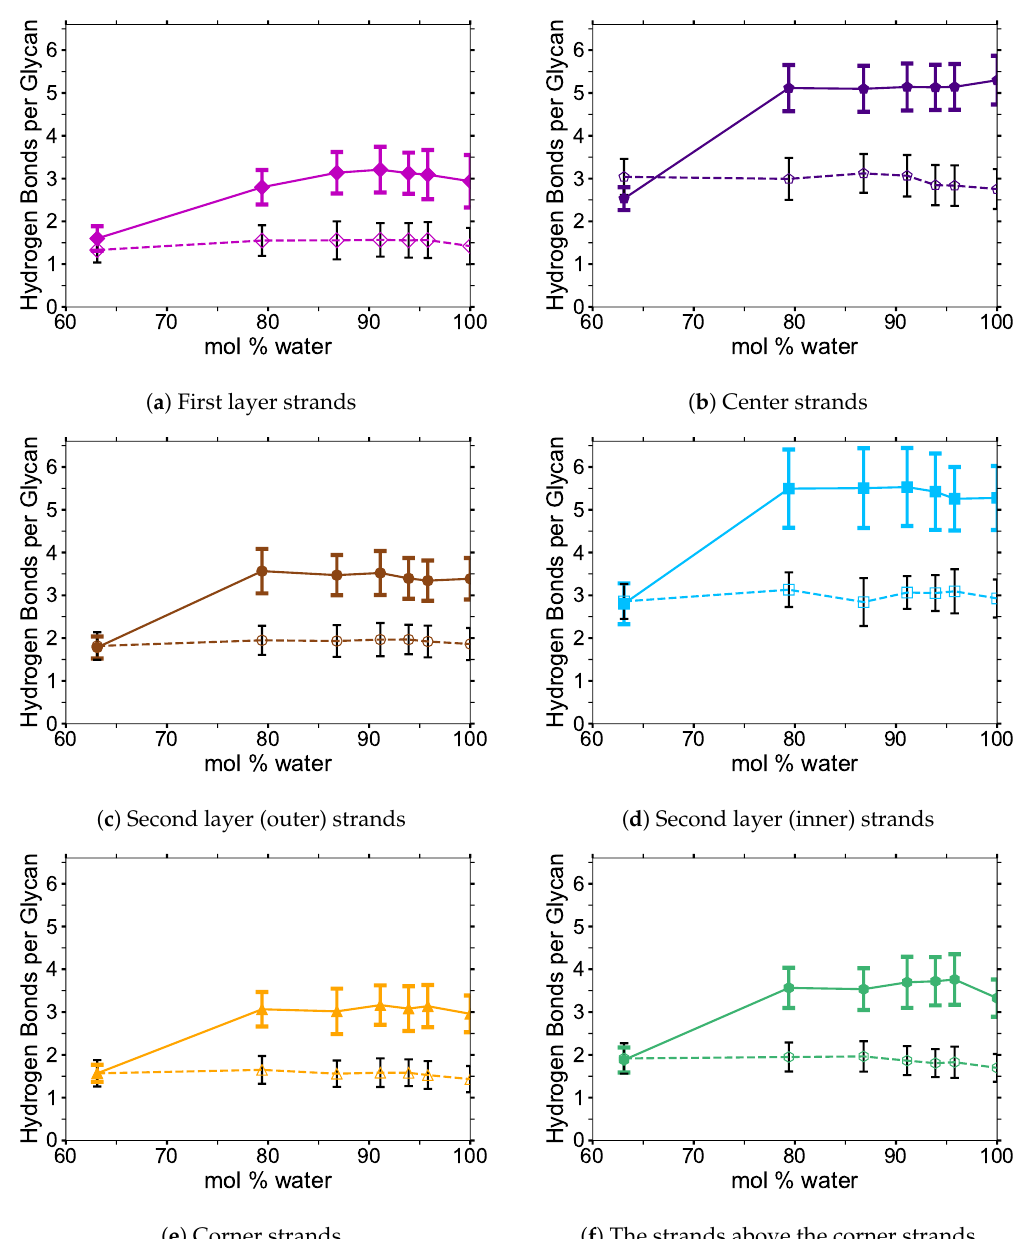
Figure A2. Average inter-strand hydrogen bonding comparison with standard deviations between the small and large cellulose bundles at various water concentrations: ( a ) the first layer strands; ( b ) the center strands; ( c ) the second layer (outer) strands; ( d ) the second layer (inner) strands; ( e ) the corner strands; ( f ) the strands above the corner strands. All data points were averaged from 10 to 20ns. The solid lines, filled markers, and colored error bars represent the large cellulose bundle, and the dashed lines, unfilled marker, and black error bars show the small cellulose bundle. The colored strands are matched and compared between the plots for the small and large bundles and the images to identify similar hydrogen bonding behavior based on their locations (see Figure 6a,b for the color-coded images). The black cellulose strands are not